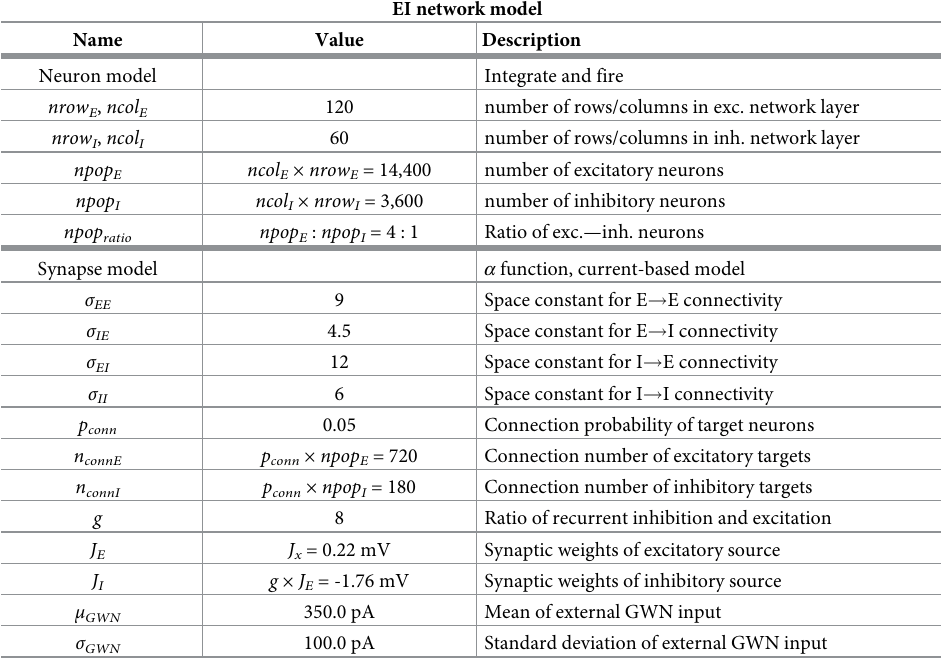
Table 3. Parameter values for the networks (top), for the connections (middle) and for an external input (bottom) in EI-network